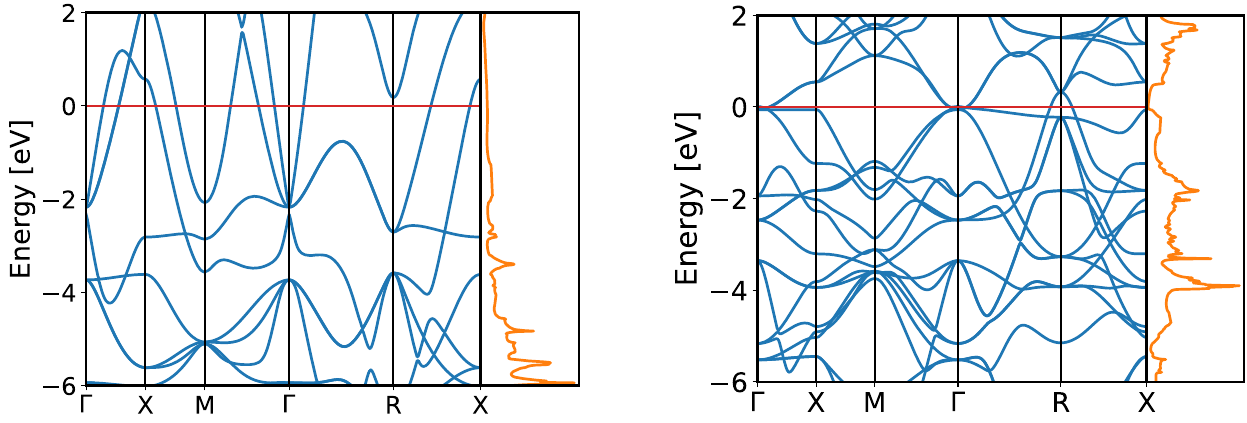
Fig. 4 Calculated band structure (left) and total density-of-states (right) for ScCRh 3 . The red line represents the Fermi